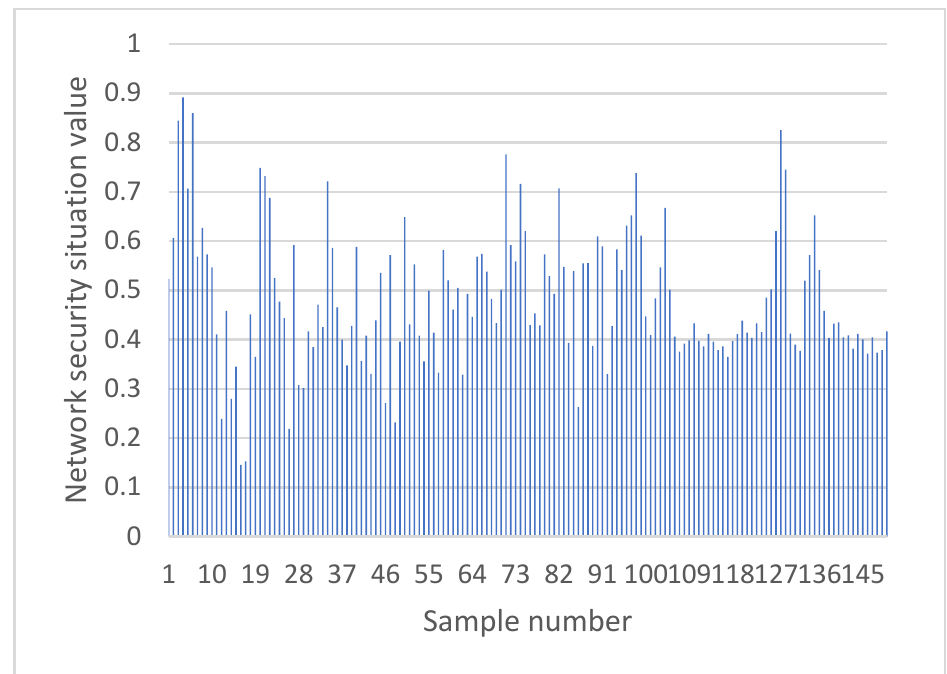
Figure 6. Network security situation value. The parameters of the ELM neural network need to be determined during the ex- periment. Because the number of neurons in the input layer of the ELM represents the dimensional characteristics of the sample data, in this paper, corresponding to the network security situation value for a certain period of time, the sliding-window method is used